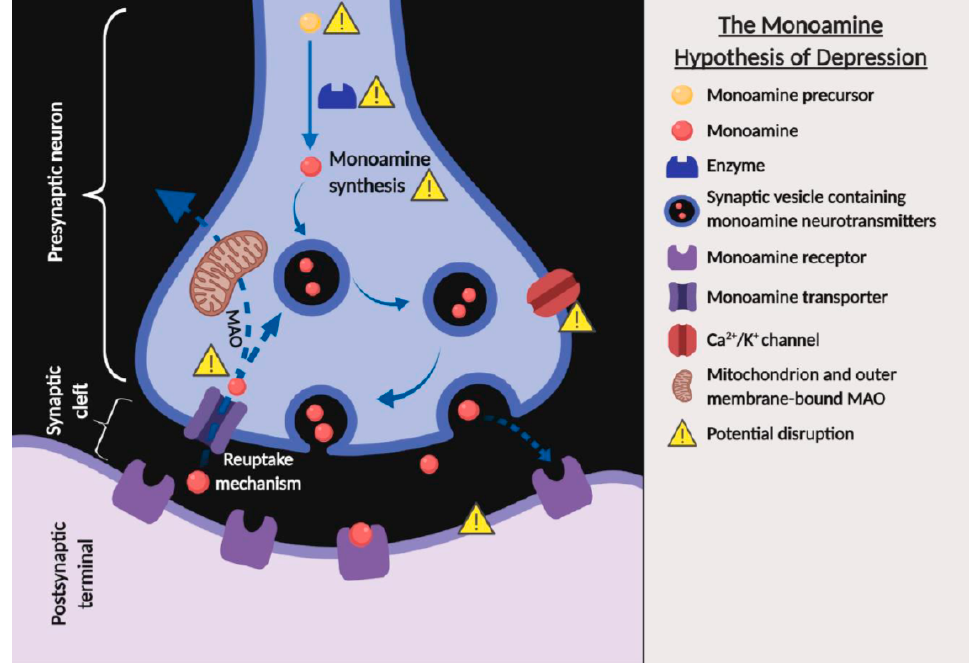
Figure 2. The monoamine hypothesis of depression showing the potential factors that can cause a deficiency in the transmission within the monoamine systems (created with BioRender.com). The